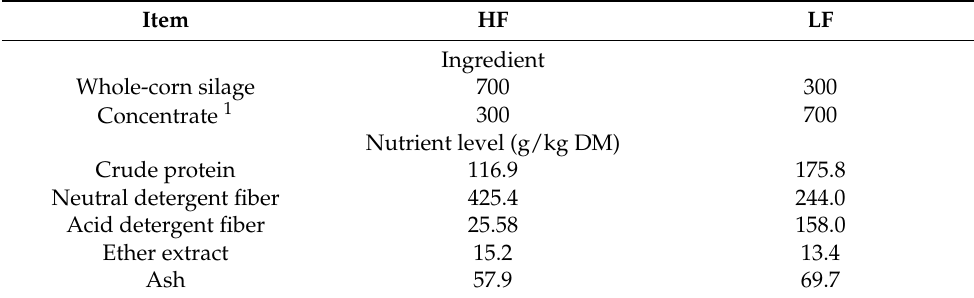
Table 1. Feed ingredients and chemical composition on dry matter basis of high-fiber (HF) and low-fiber (LF) diets for in vitro rumen